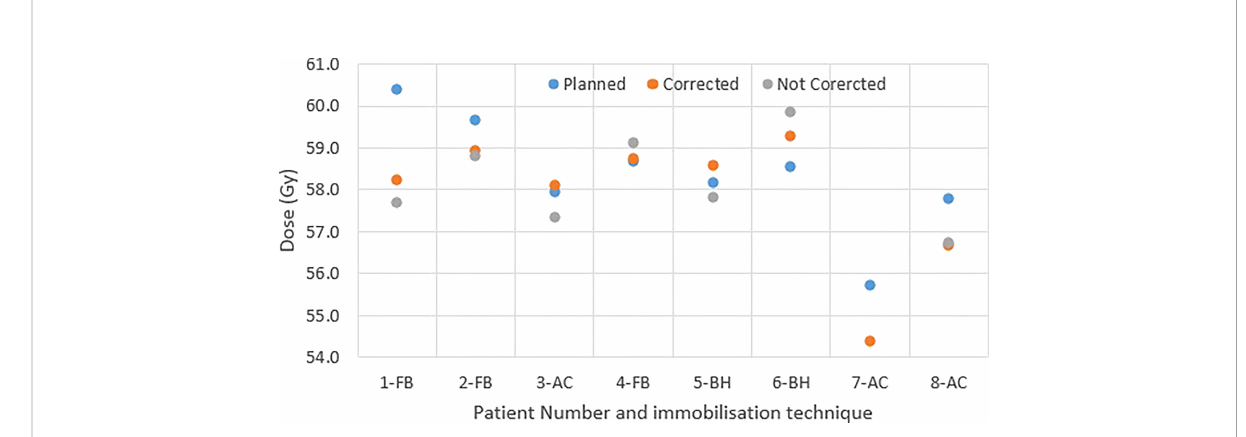
FIGURE 5 The GTV Dmax of original plan and delivery with and without position